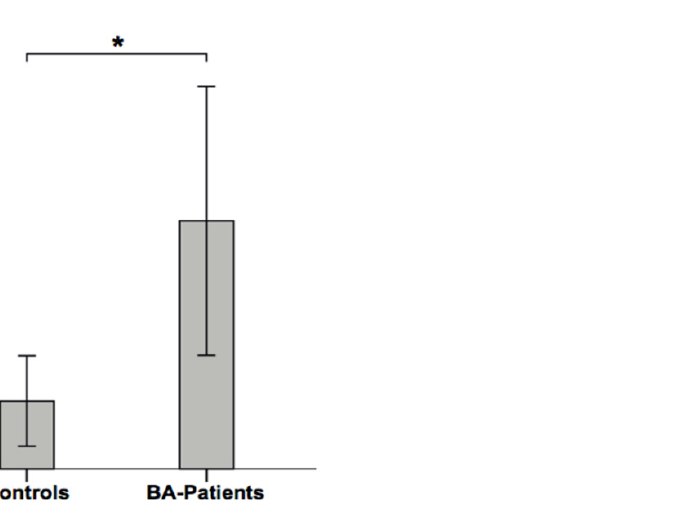
Figure 4. Comparing serum levels of effector caspases 3 and 7 in cholestatic neonates and healthy controls. A highly significant difference (*) ( p < 0.01) was observed between BA patients and healthy or cholestatic control individuals.